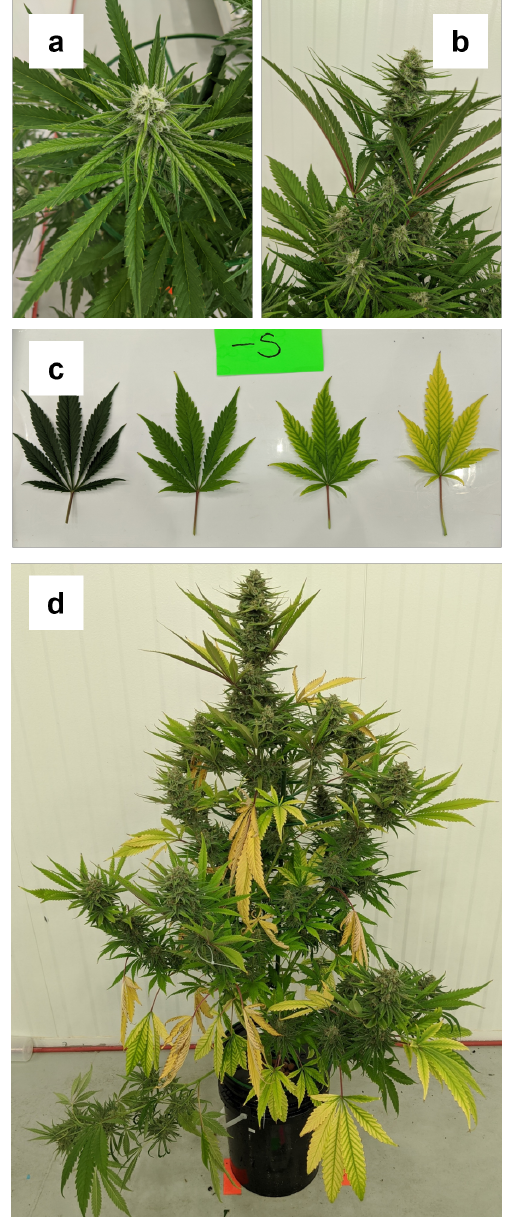
Figure 7. Progression of sulfur deficiency which first appeared as yellowing on the younger sugar leaves ( a ) and upward angled upper canopy fan leaves ( b ). In the following weeks, sulfur deficiency symptoms did not progress in the sugar leaves rather they progressed in fan leaves ( c ), as interveinal chlorosis, and were most severe in lower canopy fan leaves ( d